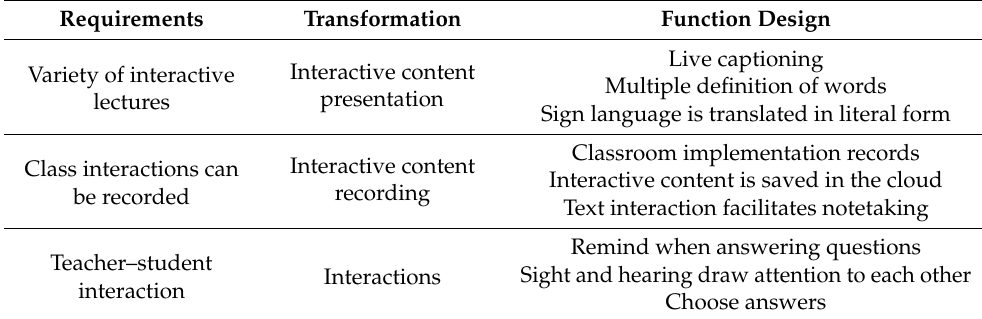
Table 2. Specific transformation from needs to functional